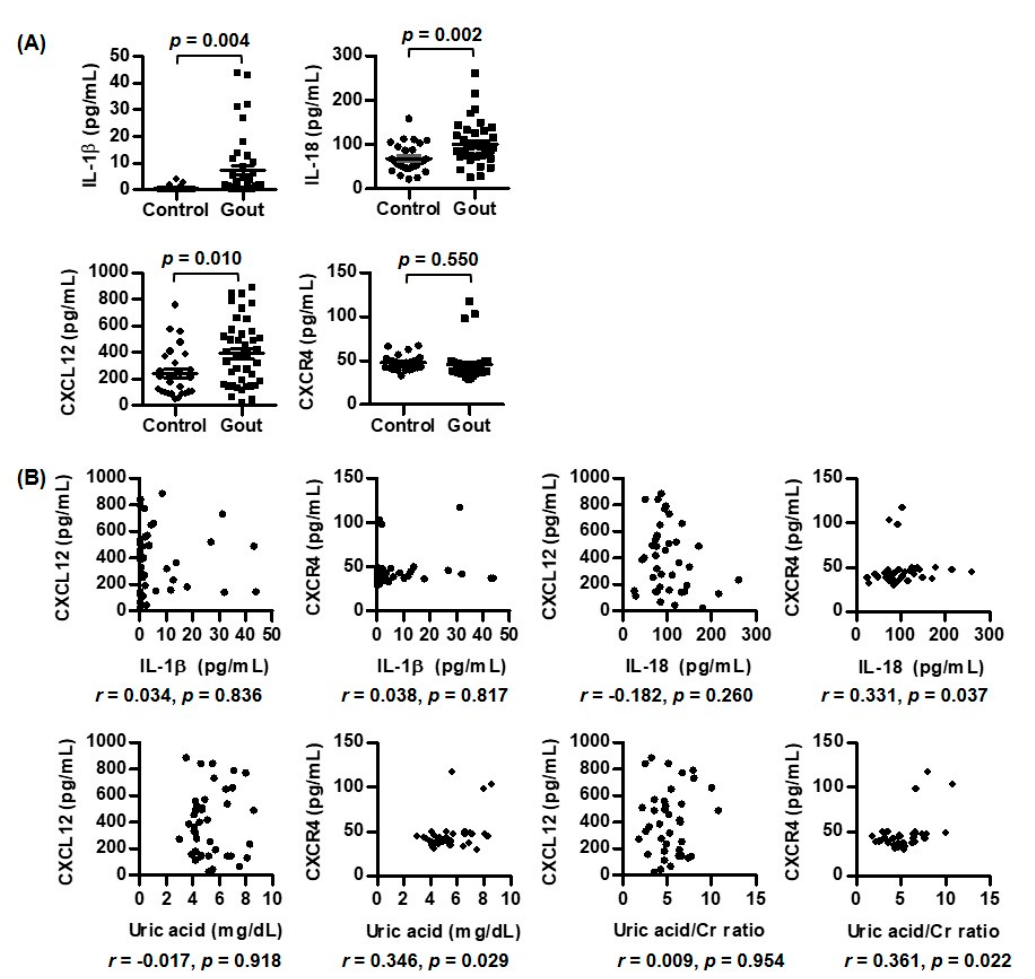
Figure 1. Serum IL-1 β , IL-18, CXCR4, and CXCL12 expression in both gouty arthritis and controls. ( A ) Comparison of serum IL-1 β , IL-18, CXCR4, and CXCL12 levels between gouty arthritis ( n = 40) and controls ( n = 27). ( B ) Correlation among serum IL-1 β , IL-18, CXCR4, CXCL12, uric acid, and uric acid/creatinine levels in patients with gouty arthritis ( n = 40).